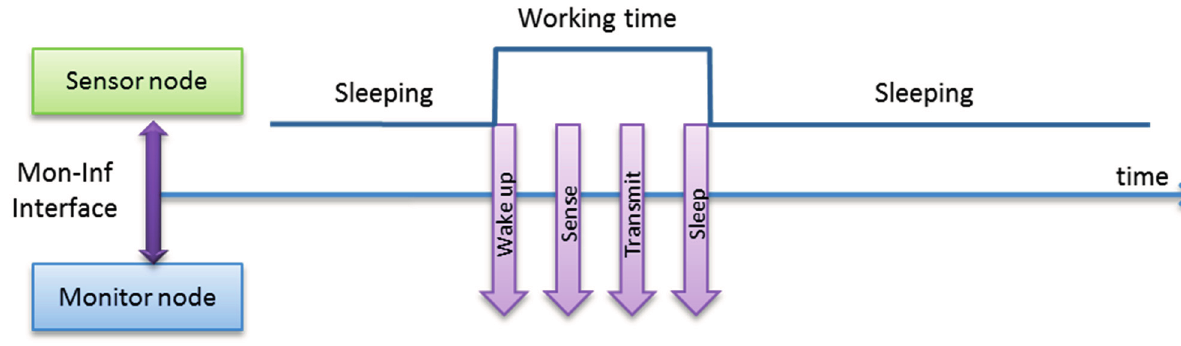
Figure 3. Hybrid monitor operation